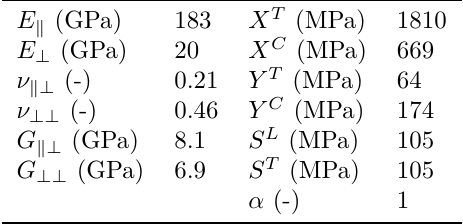
Table 1. Yarn stiffness and strength properties.